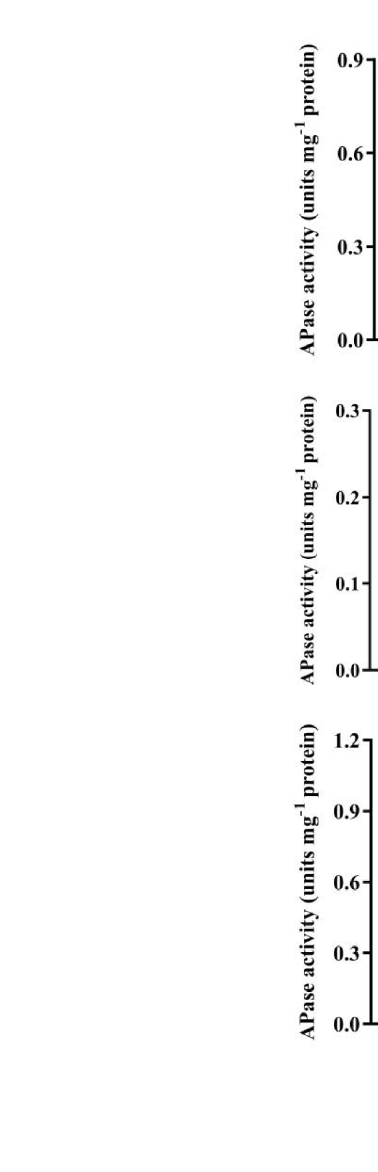
FIGURE 6 | APase activities of Col-0, AtPAP17 and AtPAP26 mutants ( atpap17 , atpap26 , and atpap17/atpap26 ) grown under +Pi (1.25 mM KH 2 PO 4 ) and − Pi (no Pi) conditions. APase activities of shoot (A) , root (B) , and seedling (C) of the lines as determined with p NPP as the substrate. Values are the means ± SE of three biological replicates. Signi fi cant differences are indicated by different letters above the bars ( P <